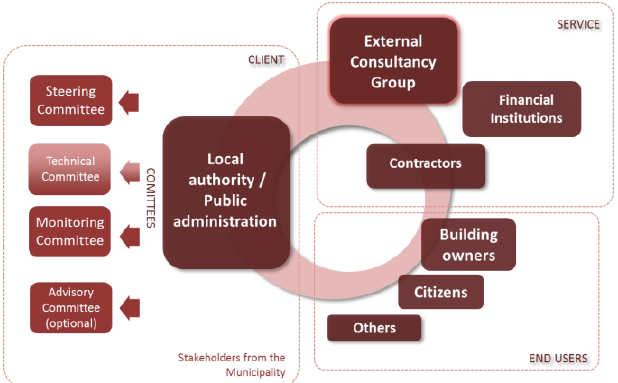
Figure 1. Stakeholders defined in the Methodology [ Error! Reference source not found.